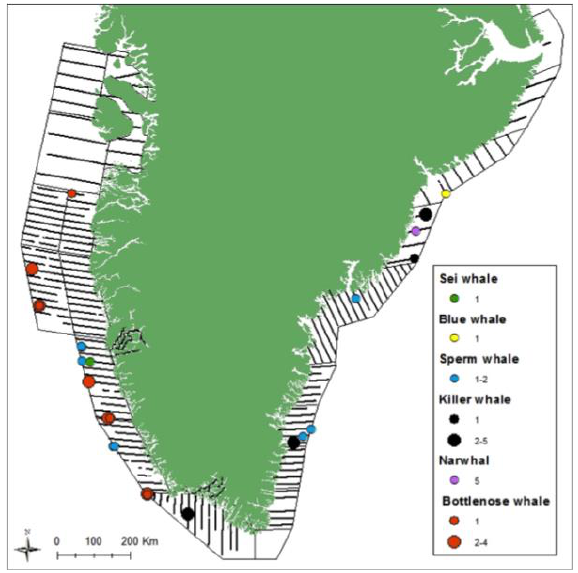
Figure 15. Survey effort in sea states <5 and sightings with group sizes of narwhals, sei, blue, sperm, bottlenose and killer whales in East and West